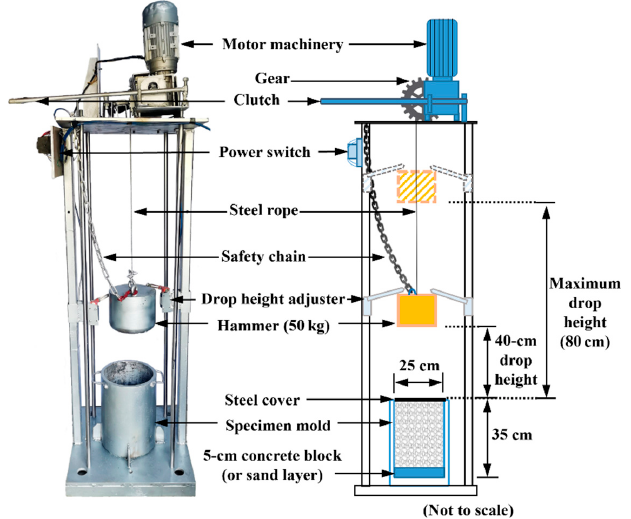
Figure 2. Illustration of the setup and configuration of the customized impact-load-test apparatus.